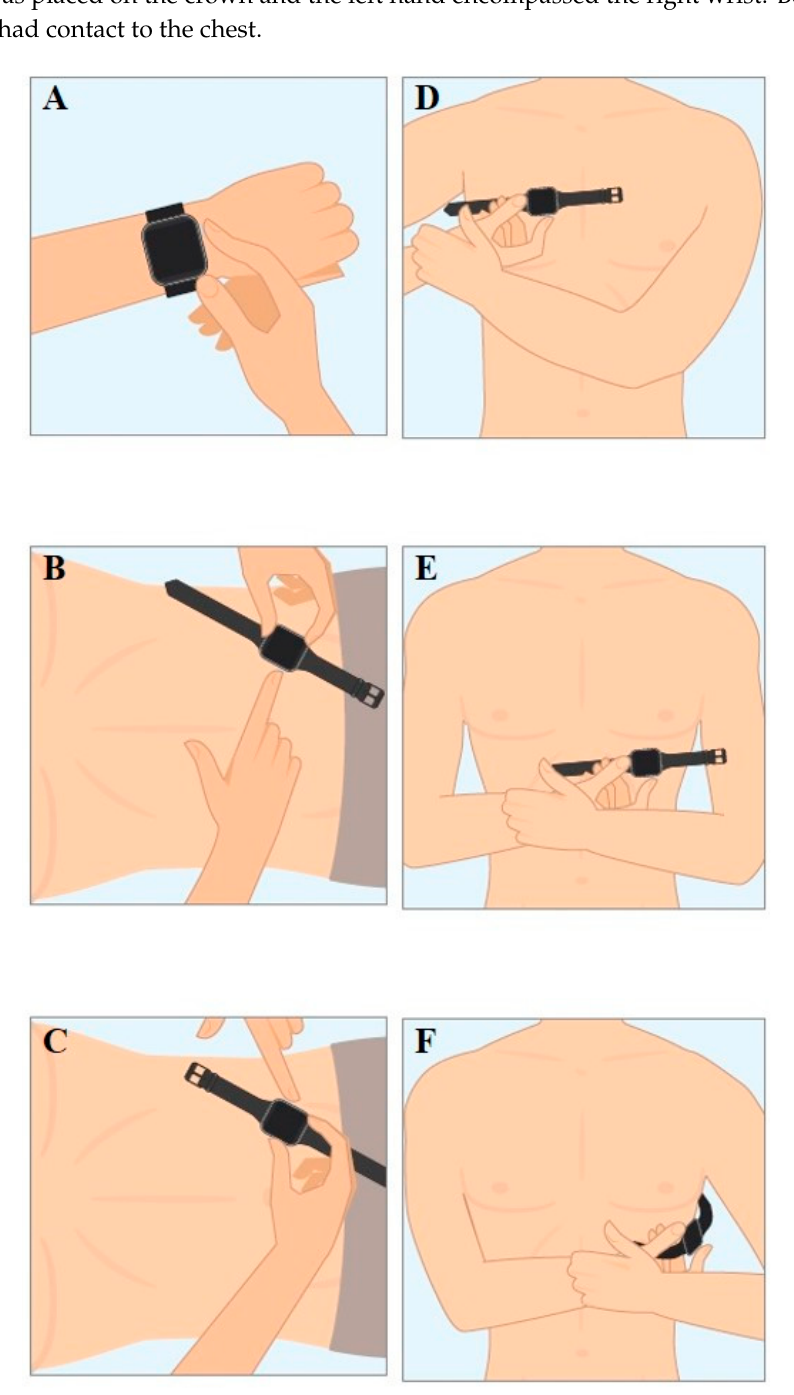
Figure 1. ( A ) Recording of Einthoven lead I between the left arm wrist and the right index finger. ( B ) Recording of Einthoven lead II between the left lower abdominal region and the right index finger. ( C ) Recording of Einthoven lead III between the left lower abdominal region and the left index finger. ( D ) Recording of Wilson-like right (Wr) with smartwatch at the fourth intercostal space right parasternal. ( E ) Recording of Wilson-like medial (Wm) with the smartwatch at the fifth intercostal space midclavicular line. ( F ) Recording of Wilson-like left (Wl) with the smartwatch at the fifth intercostal space in left midaxillary line.